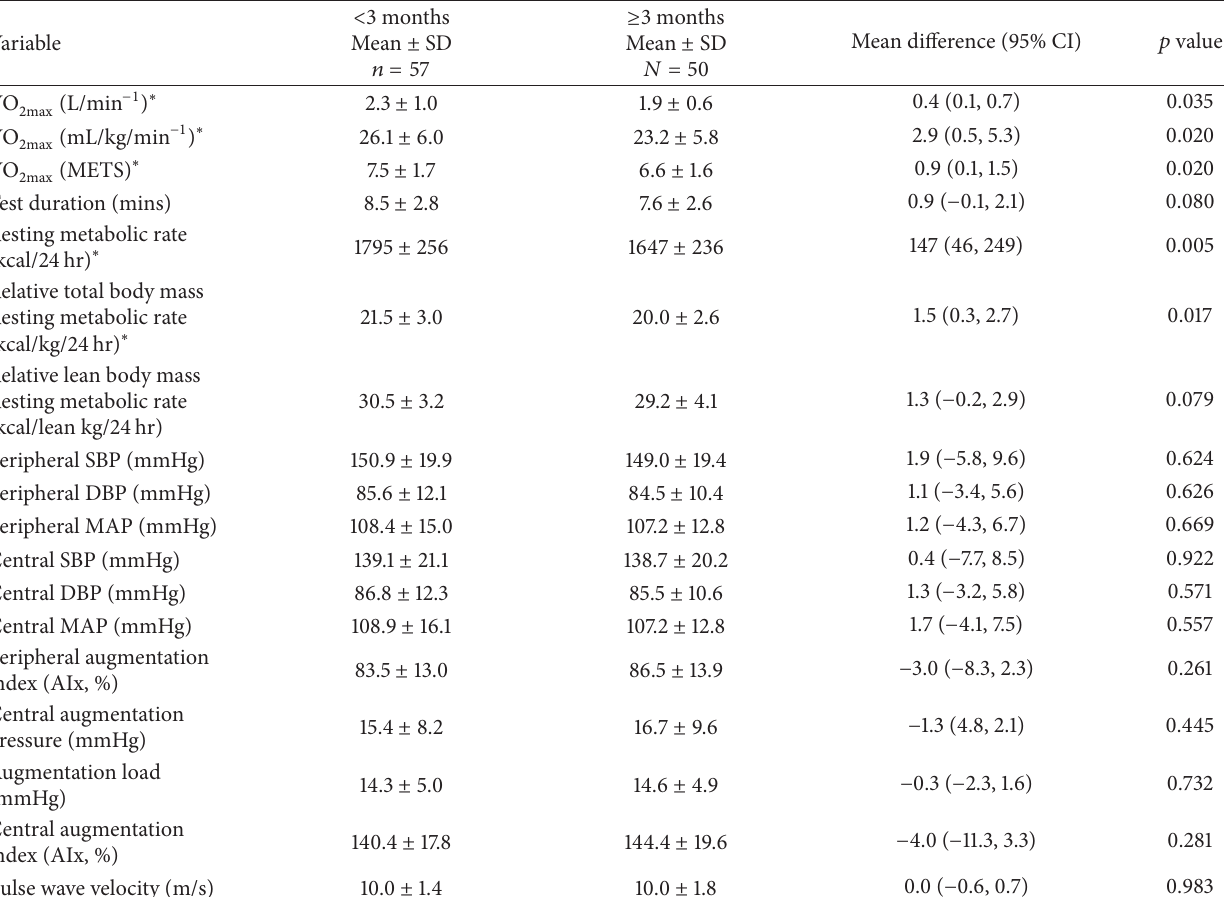
Table 3: Resting and maximal cardiorespiratory values and hemodynamic and pulse wave analysis parameters for the short- and longer-term androgen deprivation